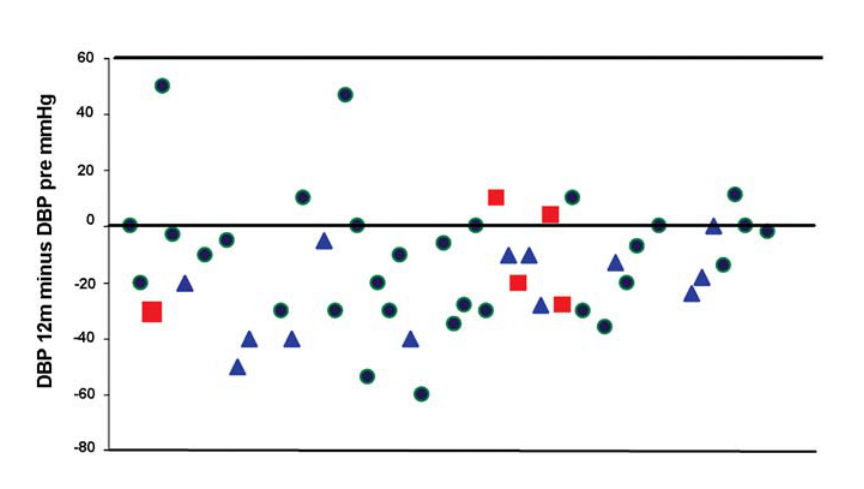
Figure 2 – Variation of SBP of each patient 12m after nephrectomy (n = 49). (cid:404)(cid:3) reduction , (cid:376)(cid:3) same and (cid:374)(cid:3) increased number of hypo- tensors.